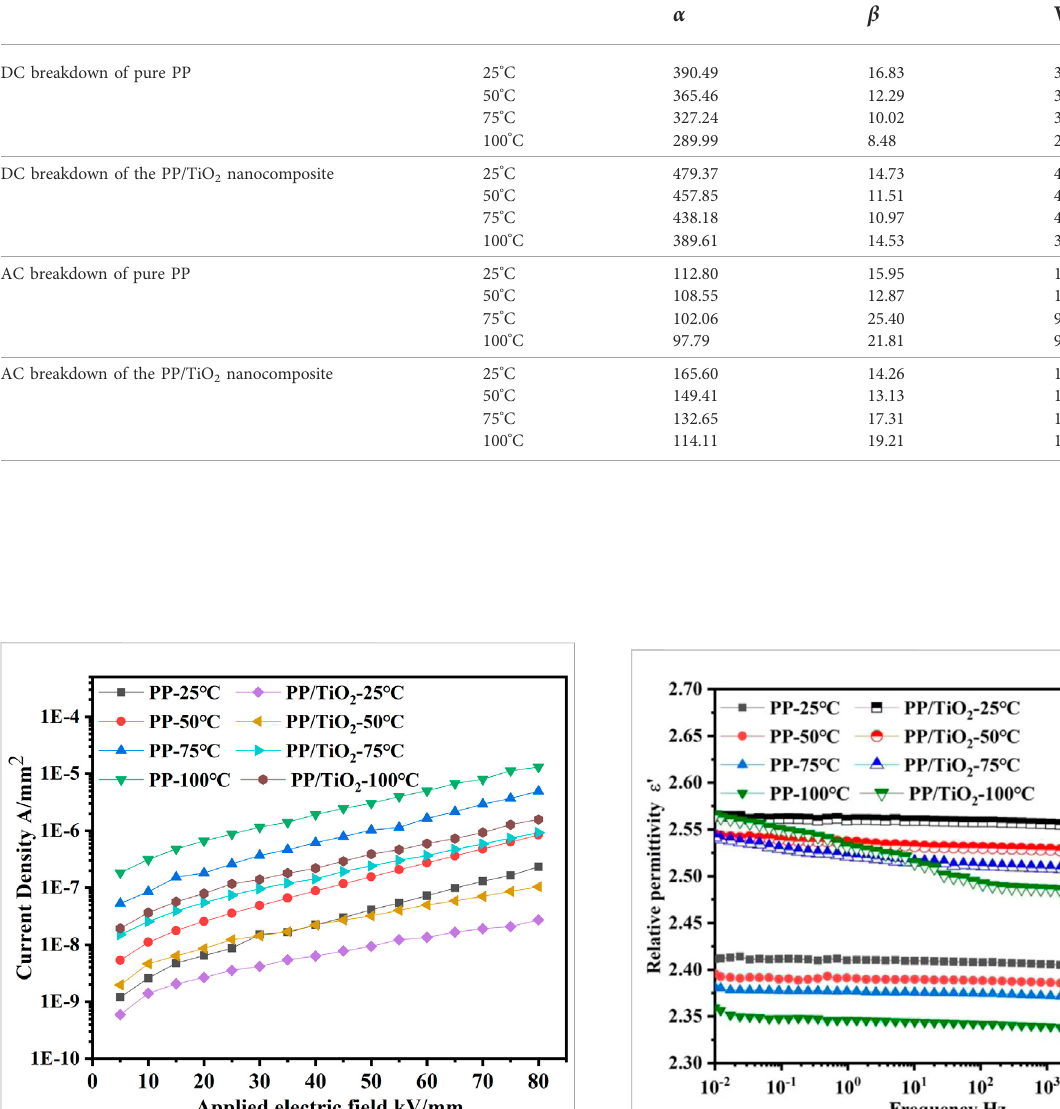
TABLE 1 Weibull parameters for DC and AC breakdown strength.